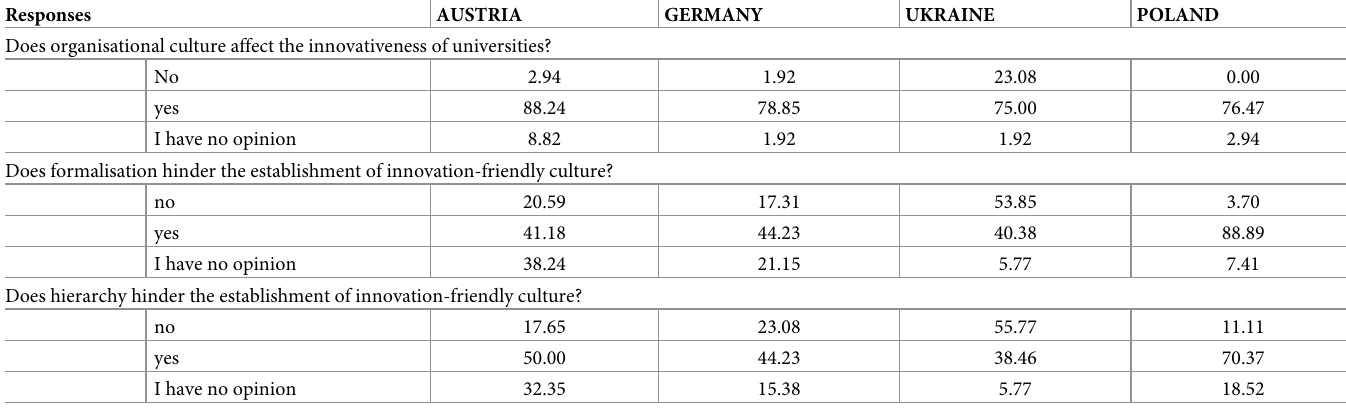
Table 3. Does organisational culture affect innovation at universities and do formalisation and hierarchy make it difficult?